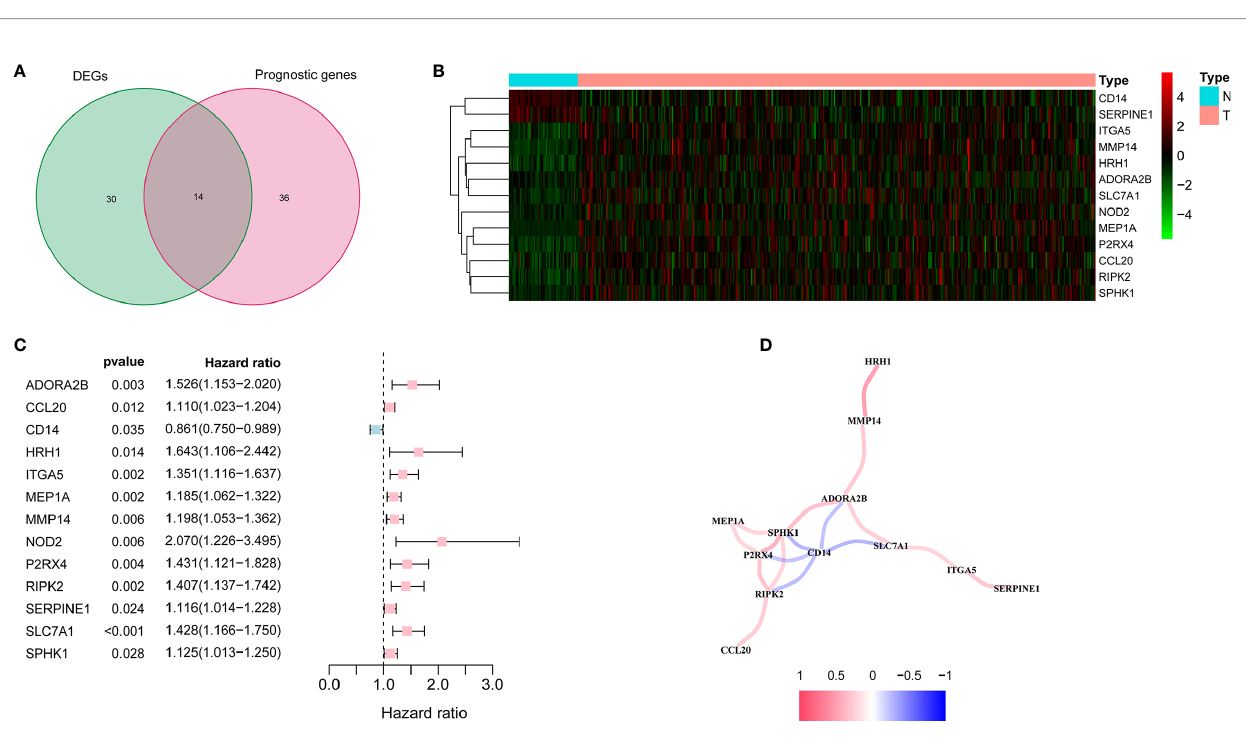
FIGURE 2 | Identi fi cation of the candidate in fl ammatory response-related genes in the TCGA cohort. (A) Venn diagram to identify DEGs between HCC tissues and adjacent normal tissues. (B) The 13 overlapping genes expression between HCC tissues and adjacent normal tissues. (C) Forest plots showing the results of the association between 13 overlapping gene expression and OS. (D) The correlation network of candidate